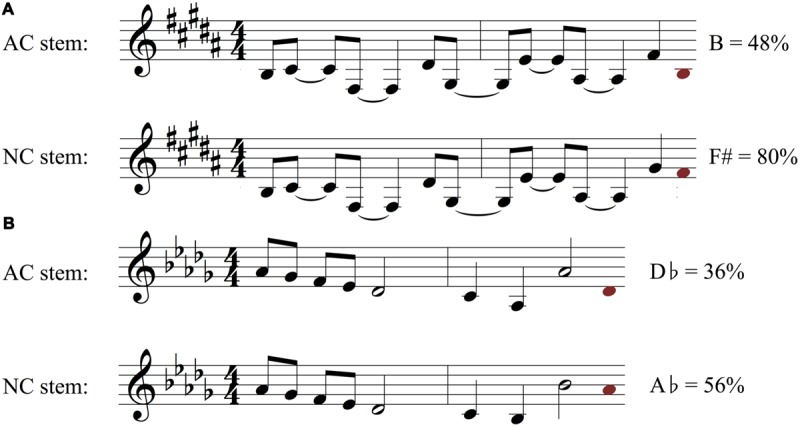
Examples of two melodic stem pairs (A,B) with an AC stem that was less constraining than the NC stem. Stems are shown in black and white, and for each stem the most frequently sung note is shown as a red note head at the end of the stem. The pitch class name of this note and the proportion of listeners who sang the note (i.e., the measured melodic constraint of the stem) are printed next to the red note. These two pairs correspond to stem pairs 40 and 45 in Figure 3.